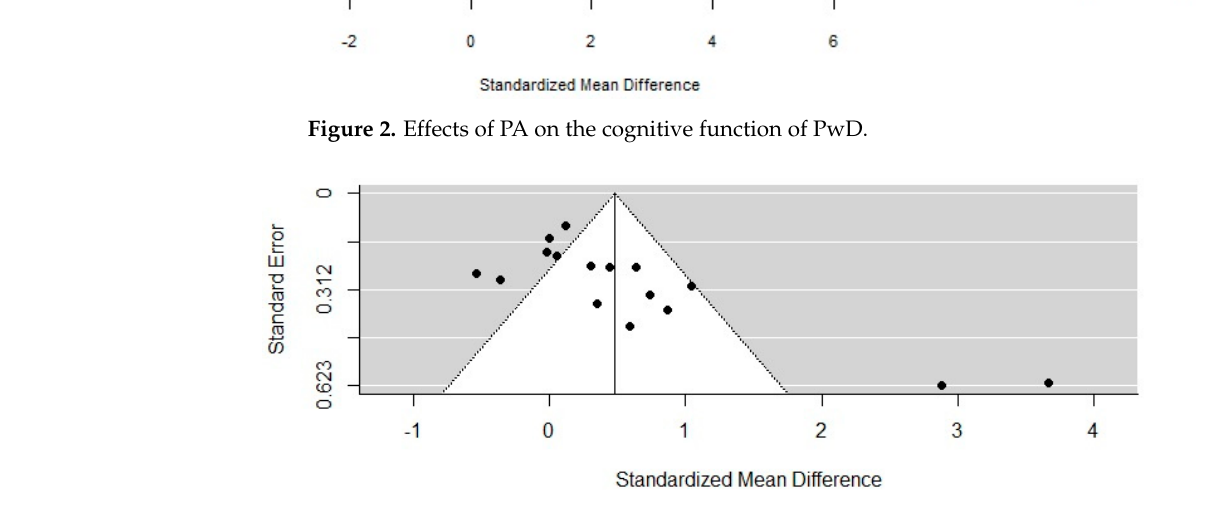
Figure 3. A funnel plot of the included studies.